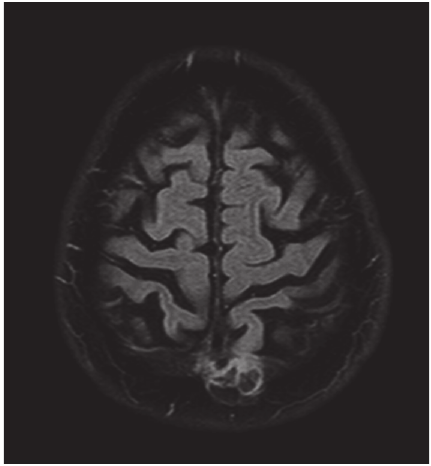
Figure 3: Coronal T2-weighted SPAIR image shows narrow neck and atrophy of the brain herniation.